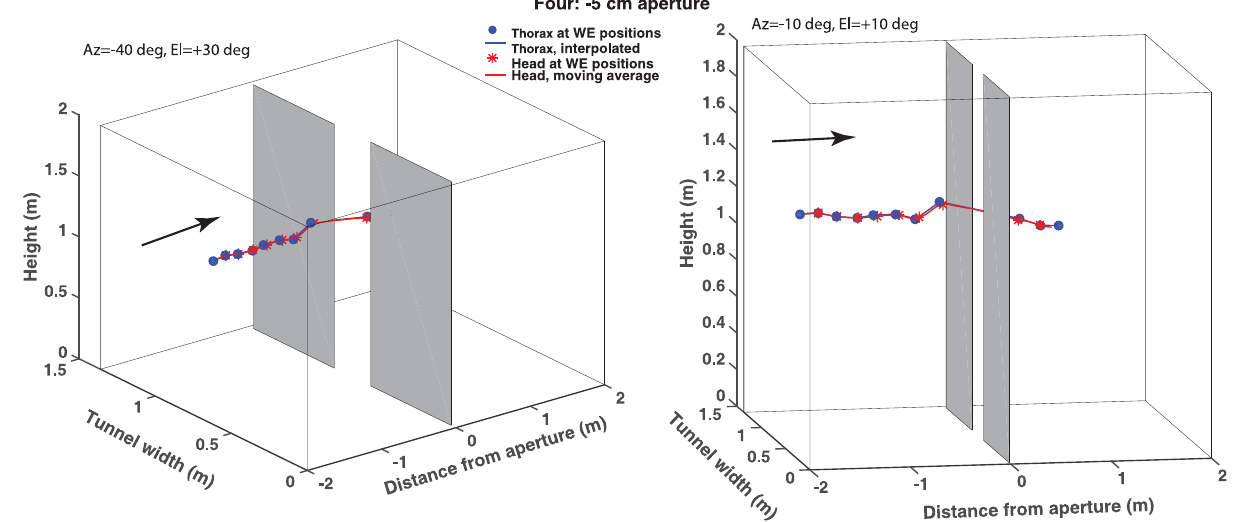
Fig 7. Two 3D views of a trajectory of bird Four during flight through an aperture that is 5 cm narrower than its wingspan. Details are as in Fig 6.